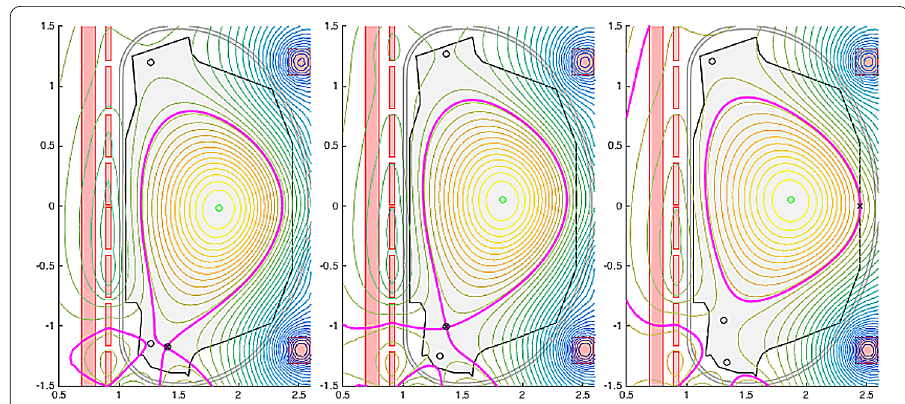
Figure 7 Example HL-2M. Contour lines of the magnetic flux ψ for three different configuration of HL-2M. The location ( r max ( ψ ), z max ( ψ )) of the maximum of ψ is indicated with a green circle. The location ( r X , z X ) of the discrete saddle points of ψ is indicated by black circles. The magenta line indicates the contour line